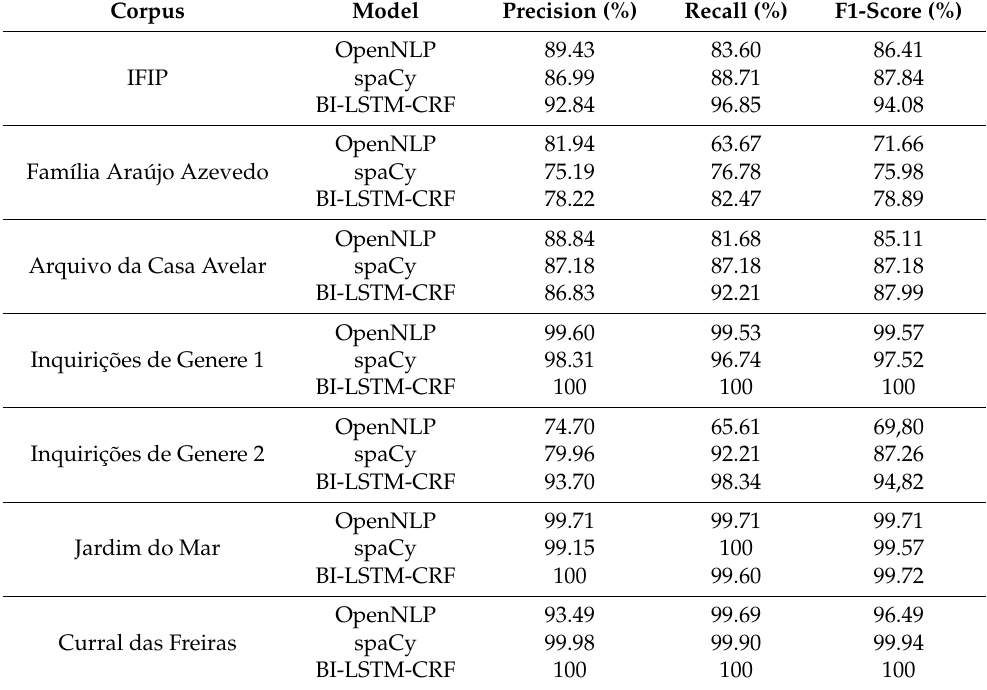
Table 3. Generalized NER model validation